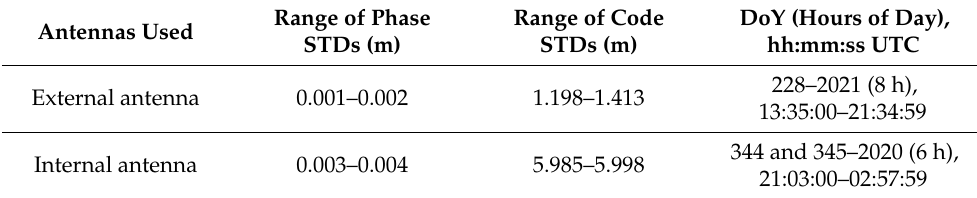
Table 1. Stochastic model settings in terms of undifferenced and zenith-referenced STD range (minimum to maximum) of the code and phase observations. In the last column, the time span of the data to be analyzed is also depicted (in universal coordinated time, UTC). Antennas